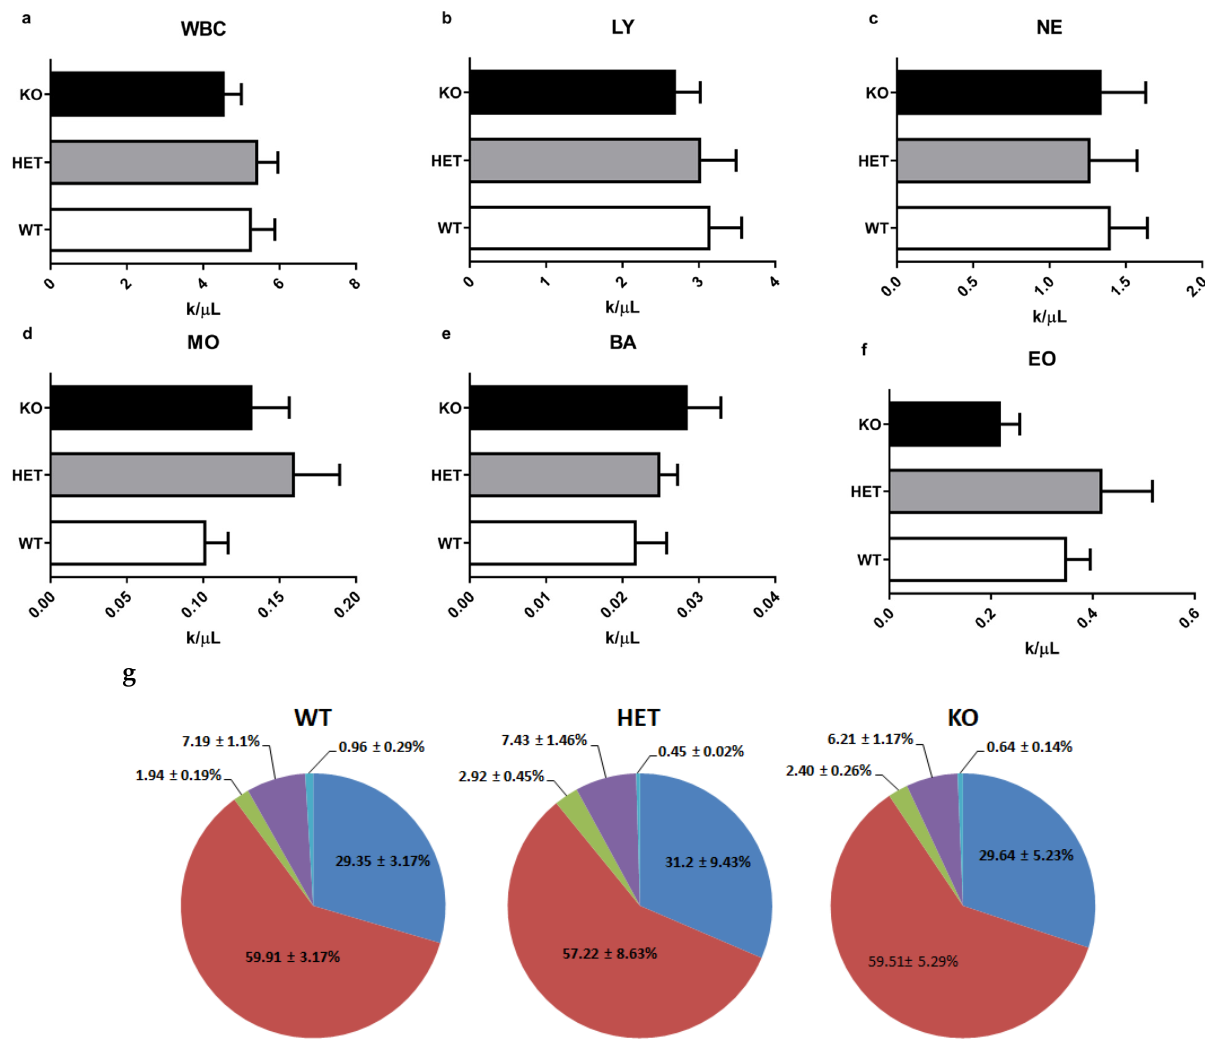
Figure 3. Differentiated WBC parameters in the blood of WT, HET, and TAAR5-KO (KO) mice. Comparative analysis revealed no significant alterations in immune cell parameters: white blood cells (WBC) in total ( a ), lymphocytes (LY) ( b ), neutrophils (NE) ( c ), monocytes (MO) ( d ), basophils (BA) ( e ), eosinophils (EO) ( f ), and leukocyte formula ( g ). Data are mean ± SEM.